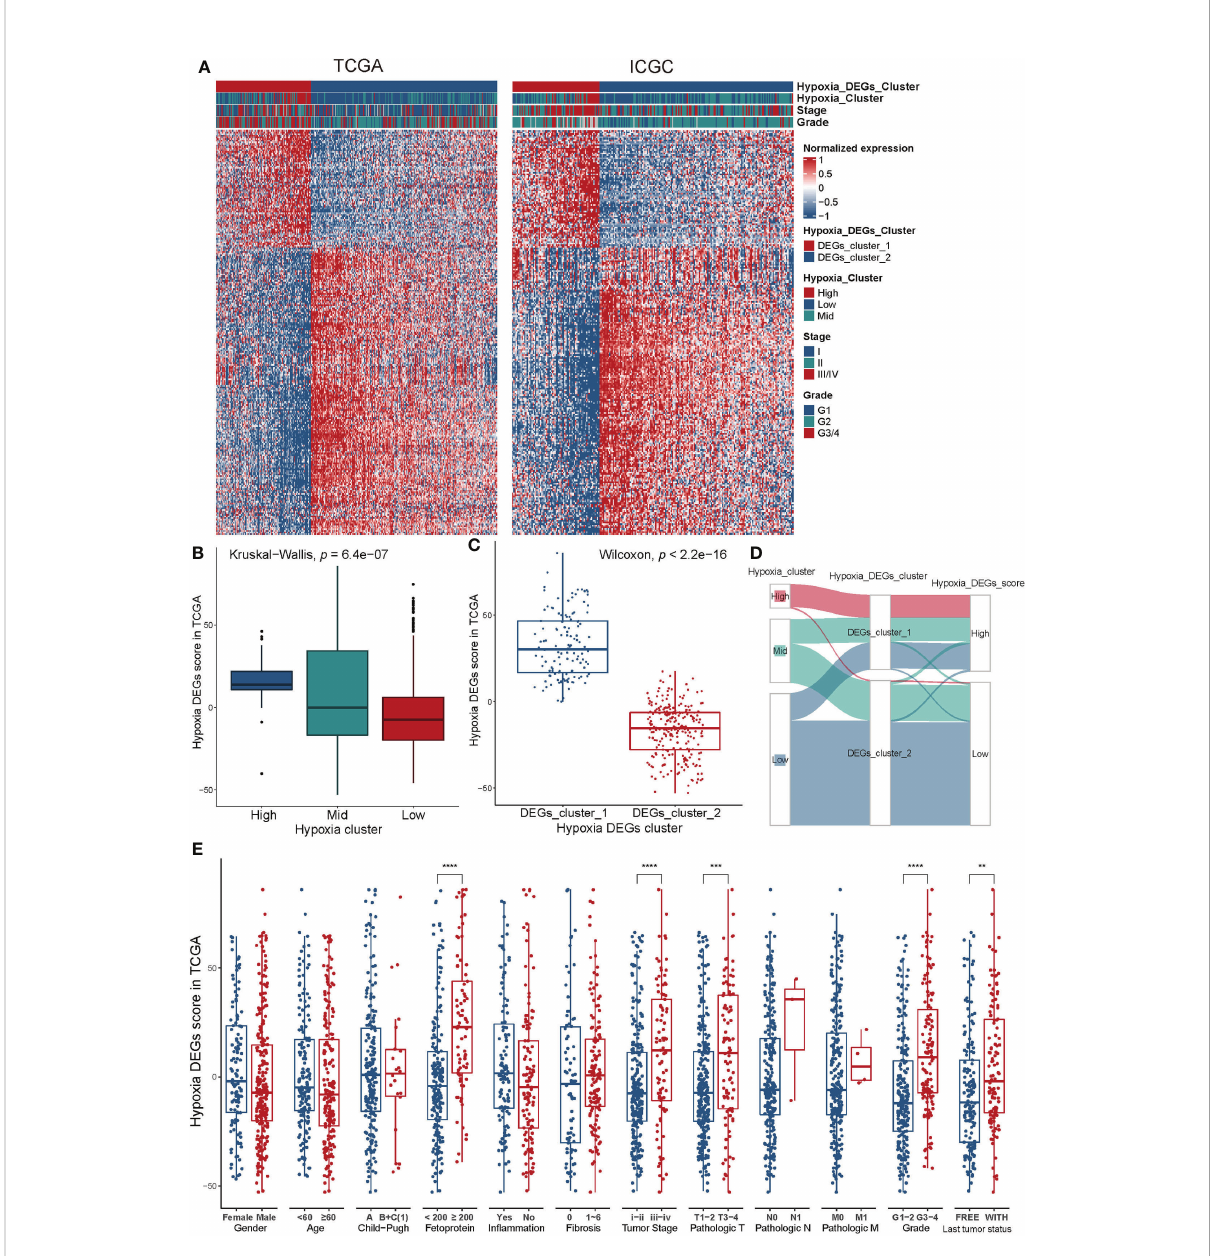
FIGURE 3 Construction of an HCC-speci fi c hypoxia signature. (A) Unsupervised clustering of the hypoxia-related differentially expressed genes in the TCGA-LIHC and ICGC-LIRI-JP cohorts. Red, high expression; blue, low expression. (B, C) Differences in the Hypoxia_DEGs_Score between hypoxia clustered groups (B) and hypoxia DEG clusters (C) in the TCGA-LIHC cohort. (D) Sankey diagram exhibiting the shifts of 15-gene hypoxia signature clusters, hypoxia DEG clusters, and Hypoxia_DEGs_Score groups based on the TCGA-LIHC cohort. The distinction between high and low Hypoxia_DEGs_Score groups is based on the optimal cutoff value of the survival analysis. (E) Differences in the Hypoxia_DEGs_Score between various clinicopathological features. The Wilcoxon test was used to determine the statistical signi fi cance of the differences. **P < 0.01, ***P < 0.001, **** P <